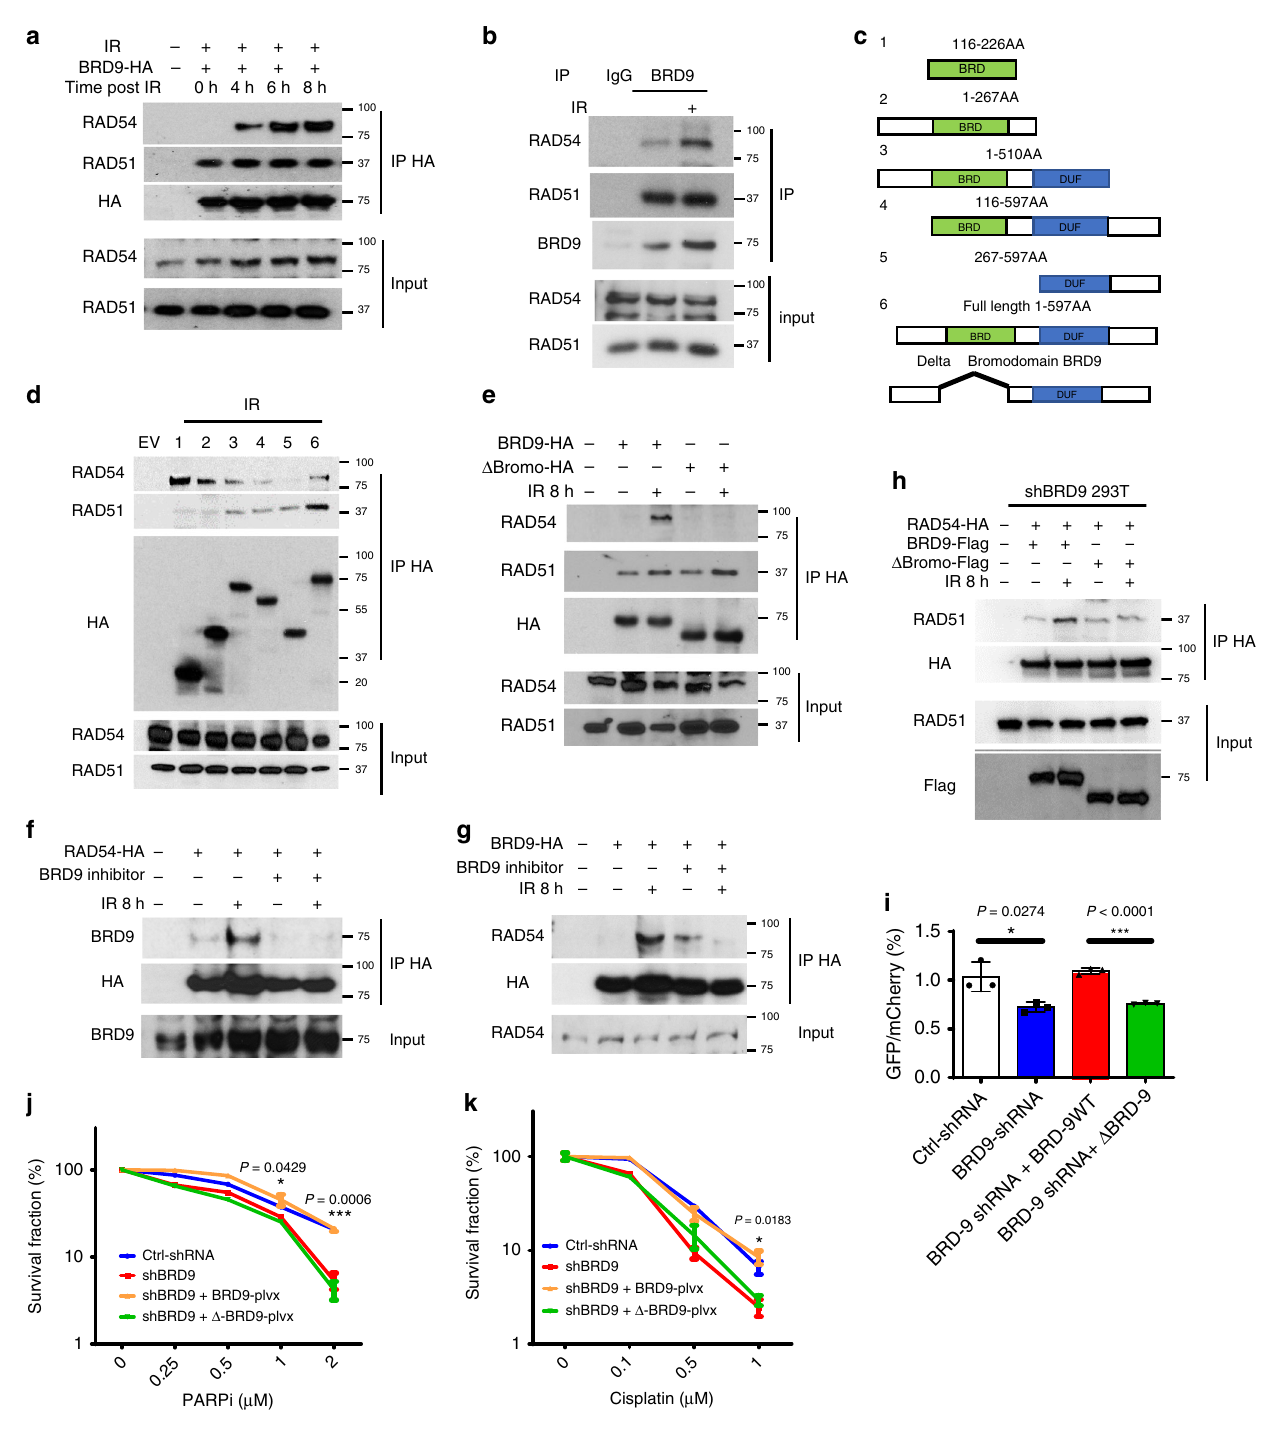
expression of BRD9 in a number of ovarian cancer and normal cell lines, and found that BRD9 was overexpressed in multiple ovarian cancer cell lines (Fig. 5c). To further examine the potential role of BRD9 as a target for cancer therapy, we knocked down BRD9 in OVCAR8 and OVCAR10 cells, ovarian cancer cell lines with high expression of BRD9, and performed colony-formation assays following olaparib, cisplatin, etopo- side, and IR treatment. Depletion of BRD9 signi fi